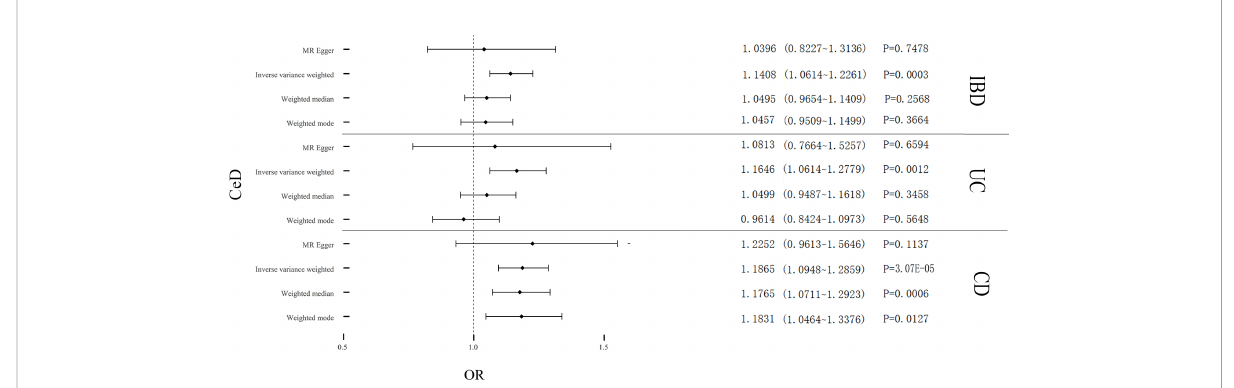
FIGURE 2 Causal estimates given as odds ratios (ORs) and 95% con fi dence intervals for the effect of CeD on IBD, UC, and CD. CeD, Celiac Disease; IBD, In fl ammatory Bowel Disease; UC, Ulcerative Colitis; CD, Crohn ’ s